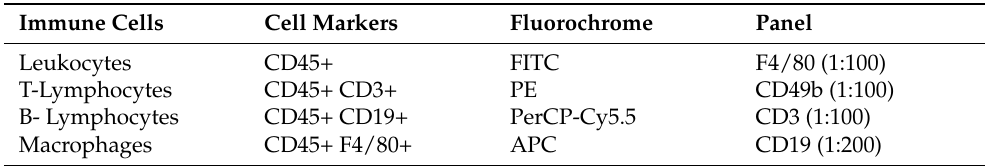
Table 4. Immune cell populations based on the expression of cell surface markers [12] and specifica- tion of used anti-mouse monoclonal antibodies